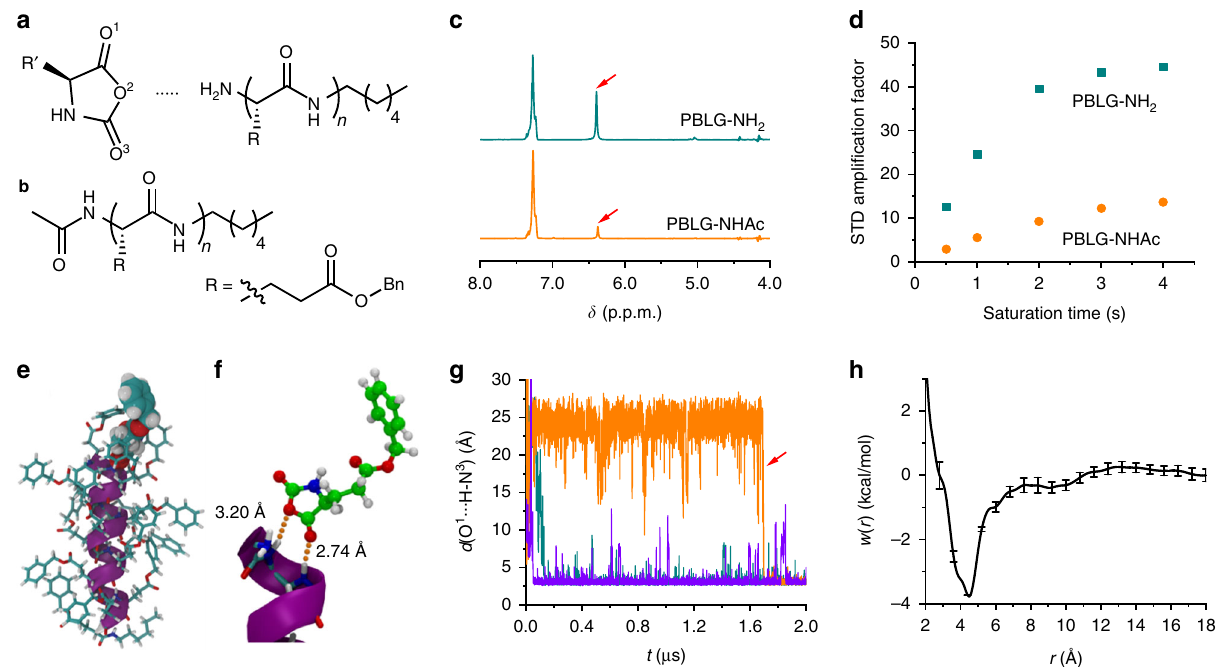
Fig. 3 Reversible binding of polypeptide and NCA monomer. a , b Chemical structures of BLG-NCA, PBLG-NH 2 a and PBLG-NHAc b . c STD NMR spectra of ELG-NCA in the presence of PBLG-NH 2 or PBLG-NHAc. The STD signal of ring N ‒ H proton is highlighted with red arrows. The peak at 7.27 ppm is the irradiation peak since no background suppression was applied. d STD ampli fi cation factor of ring N ‒ H proton of ELG-NCA in the presence of PBLG-NH 2 or PBLG-NHAc at various saturation times. e Snapshot of simulation trajectories showing the binding between PBLG-NH 2 and BLG-NCA. The α -helical backbone is represented as a purple ribbon, the side chains of PBLG as sticks, and NCA as van der Waals spheres. f Closeup from the simulation trajectory at the N terminus of PBLG-NH 2 to reveal the H-bonding interactions (highlighted with the orange dotted lines). Side chains are omitted for simplicity. g Time evolution of the H bonds formed between BLG-NCA (O 1 ) and PBLG-NH 2 (amide N – H from third residue). Each line represents one independent, 2- μ s long MD simulation. The red arrow indicates the transfer of NCA from C terminus to N terminus in the third simulation run. h PMF pro fi le for the reversible binding of PBLG-NH 2 and BLG-NCA. Error bars correspond to estimated standard deviations from four independent walkers of the eABF